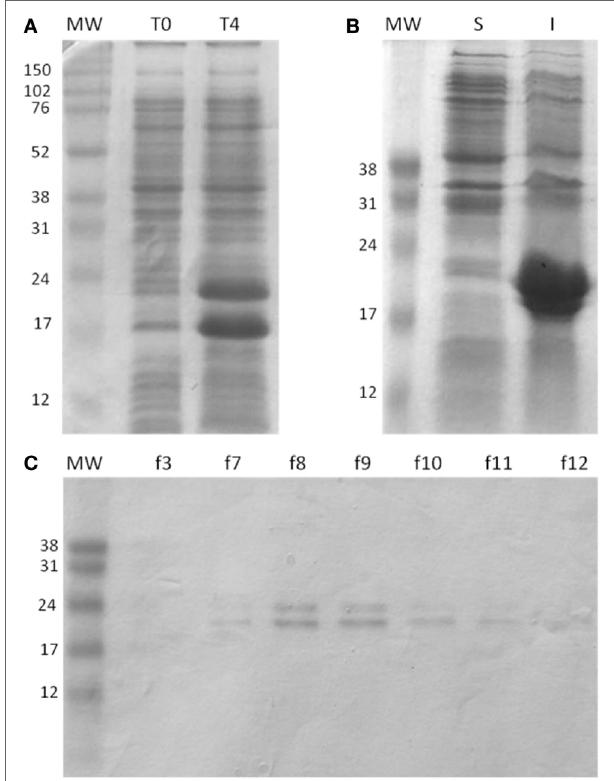
FigUre 4 | Expression and purification of rMEPLox. The protein was analyzed by SDS/PAGE (15% gel) under reducing conditions and Coomassie Blue staining. (a) Expression of rMEPLox. T0: negative control without induction by IPTG; T4: the expression of rMEPLox induced by IPTG (0.6 mM at 37°C for 4 h). (B) Solubility analysis of the induced expression of rMEPLox. S: clarified supernatant of the induced recombinant pET-26b-rMEPLox culture; I: insoluble pellet of the induced recombinant pET-26b-rMEPLox culture. (c) Purification in HisTrapTM HP of rMEPLox. Each lane corresponds to a fraction obtained in the purification. MW: protein marker.